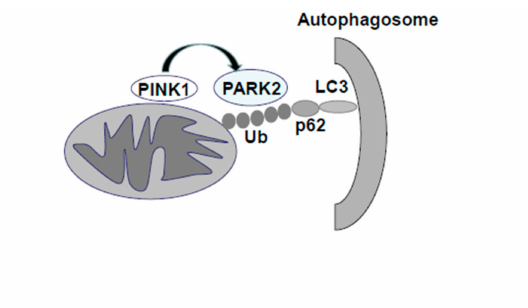
Figure 2. The regulation of mitophagy by the PTEN-induced putative kinase 1 (PINK1)–PARK2 system. When mitochondria are damaged by severe stresses, stress-induced membrane depolarization stabilizes PINK1, and PINK1 recruits PARK2. PARK2 ubiquitinates mitochondrial proteins, and the ubiquitinated proteins connect to microtubule-associated protein 1 light chain 3 (MAP1LC3/LC3) on phagophores through the adaptor protein SQSTM1/p62, resulting in autophagosome